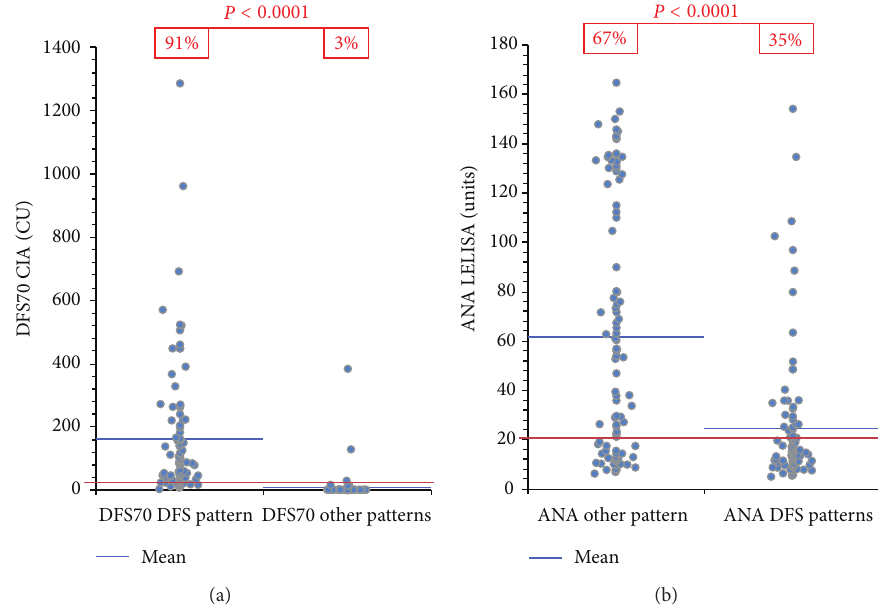
F 2: Antinuclear antibodies measured by ELISA and anti-DFS70 antibodies by chemiluminescent immunoassay (CIA) in samples with DFS pattern versus samples with other patterns. (a) Anti-DFS70 antibodies were signi�cantly more prevalent (91.0 titers higher in samples with DFS pattern compared to samples with other patterns ( signi�cantly less prevalent (35.0 ) and their titers lower in samples with DFS pattern compared to samples with other patterns ). Cut-off values are indicated by the red 𝑃𝑃 𝑃 𝑛𝑃𝑛𝑛𝑛𝑛